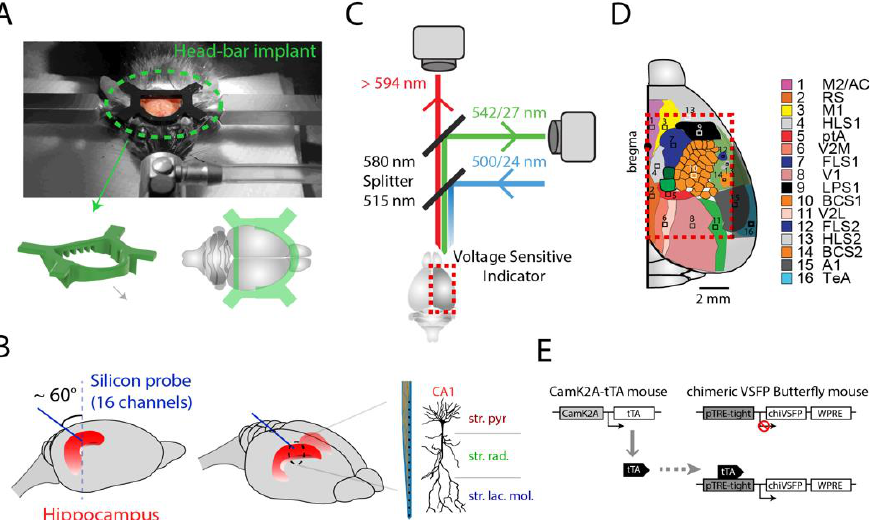
Figure 1. Implant procedures for combined widefield cortical imaging and hippocampal electrophysiology recordings. ( A ) Head-fixation bar implantation on a mouse placed in the stereotaxic apparatus. ( B ) Schema of high-density silicon probe (16 channels) implantation into the hippocampus. With 50 μm spacing between the contacts, the probe can cover all layers in CA1. Note that the implant is in the posterior part of the cortex, specifically close to the lambdoid suture, thus leaving the entire cortical area unobstructed in the optical imaging field of view. ( C ) Dual emission macroscope used for widefield cortical optical voltage imaging. The fluorescence emissions of the voltage indicator from the superficial cortical tissue was recorded by two synchronized cameras, and subsequently used for ratiometric analysis. ( D ) Topographic map of the multiple areas that can be imaged together by the macroscope (topographic image adapted with permission from Ref. [2]). ( E ) Schematic diagram of the GEVI line of transgenic mice used; CaMK2A-promoter-controlled chimeric VSFP Butterfly (chiVSFP) expression in pyramidal cells (CaMK2A-tTA;tetO-chiVSFP)